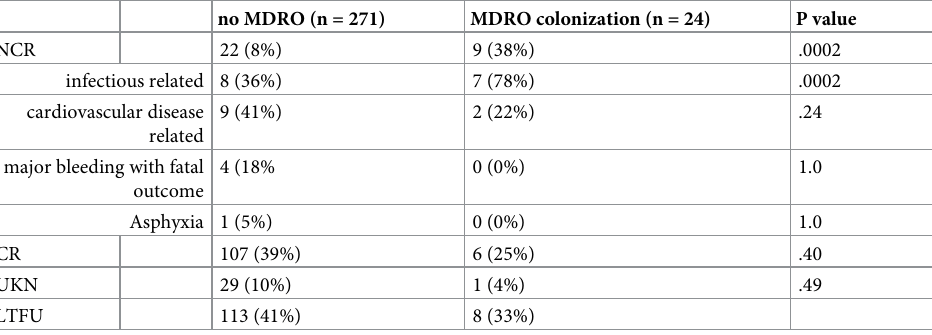
113 (41%) 8 (33%) Causes of death were compared using fishers exact test. NCR, non-cancer related mortality; CR, cancer-related; UKN, unknown; LTFU, lost to follow up; MDRO Multi Drug Resistant Organism; assessed using Fisher’s Exact